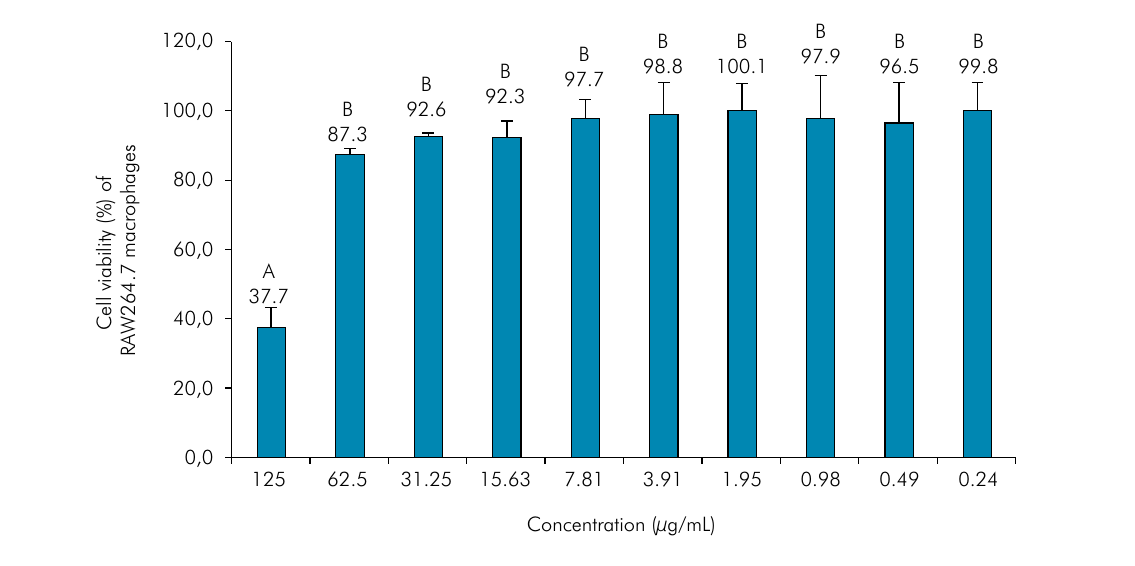
Figure 3. Percentage of cell viability of RAW 264.7 macrophage line according different concentrations of G. graciliflora leaves